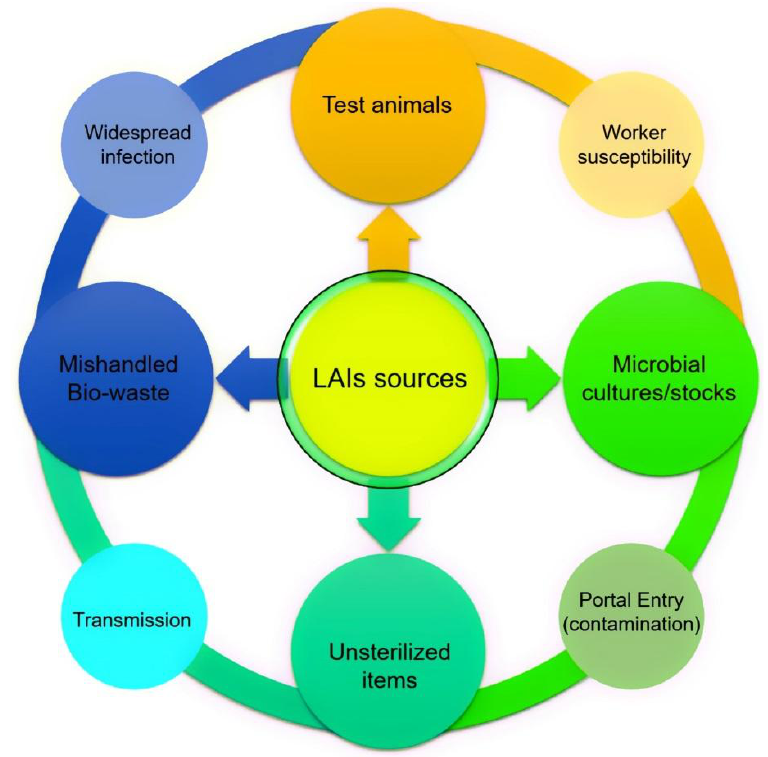
Figure 1. Laboratory-acquired infections (LAIs) sources, the outer circle shows a possible chain of infection causing